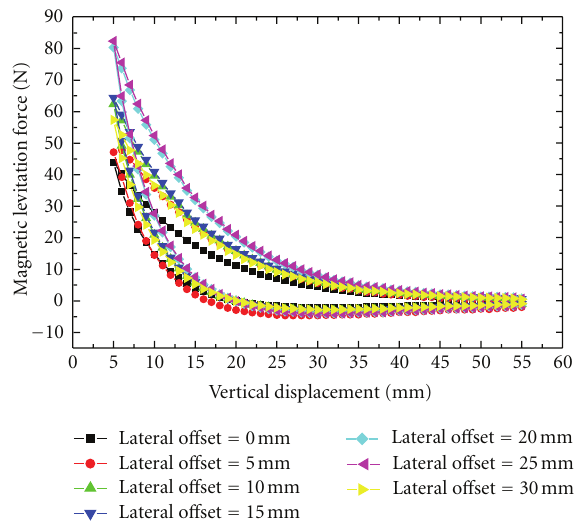
Figure 4: Magnetic levitation force loops of bulk HTS over symmetrical PMG with di ff erent lateral o ff sets.